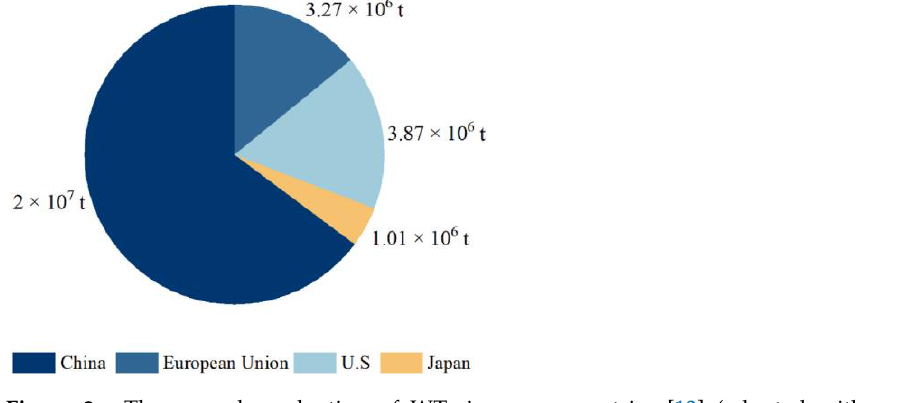
Figure 2. The annual production of WTs in some countries [13] (adapted with permission from Elsevier).